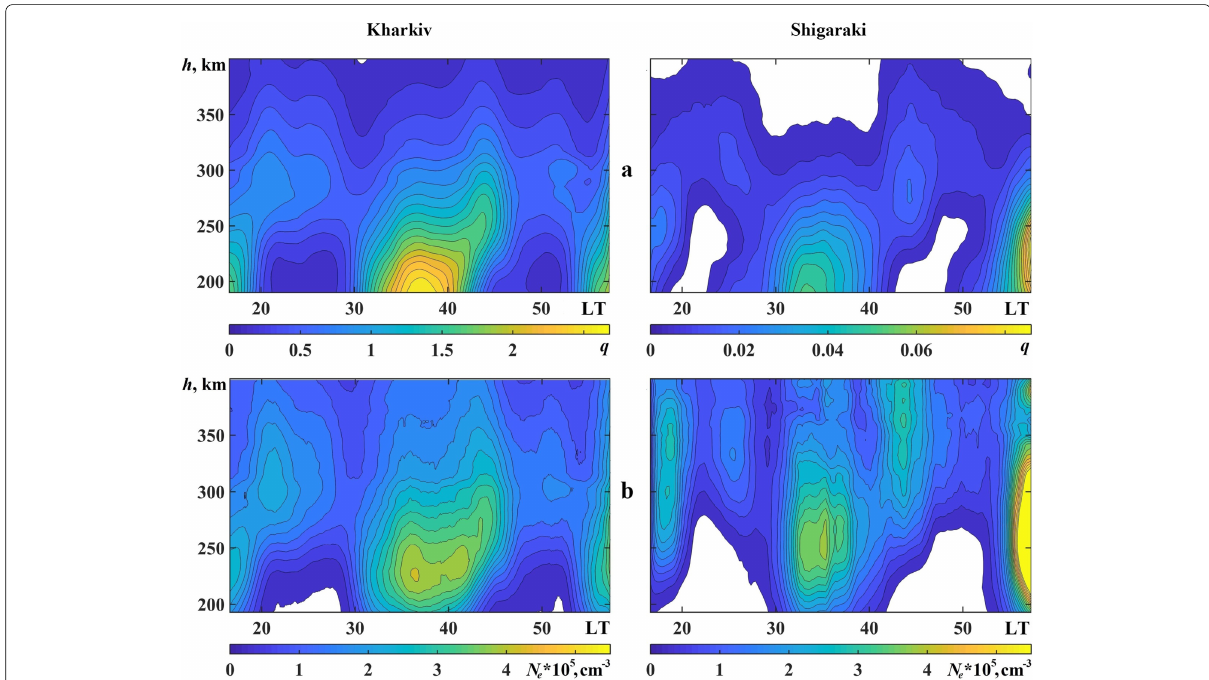
Fig. 2 Signal-to-noise ratio (top) and electron density (bottom) behavior over Kharkiv and Shigaraki during joint measuring campaign on 5–6 September 2017. LT is solar apparent